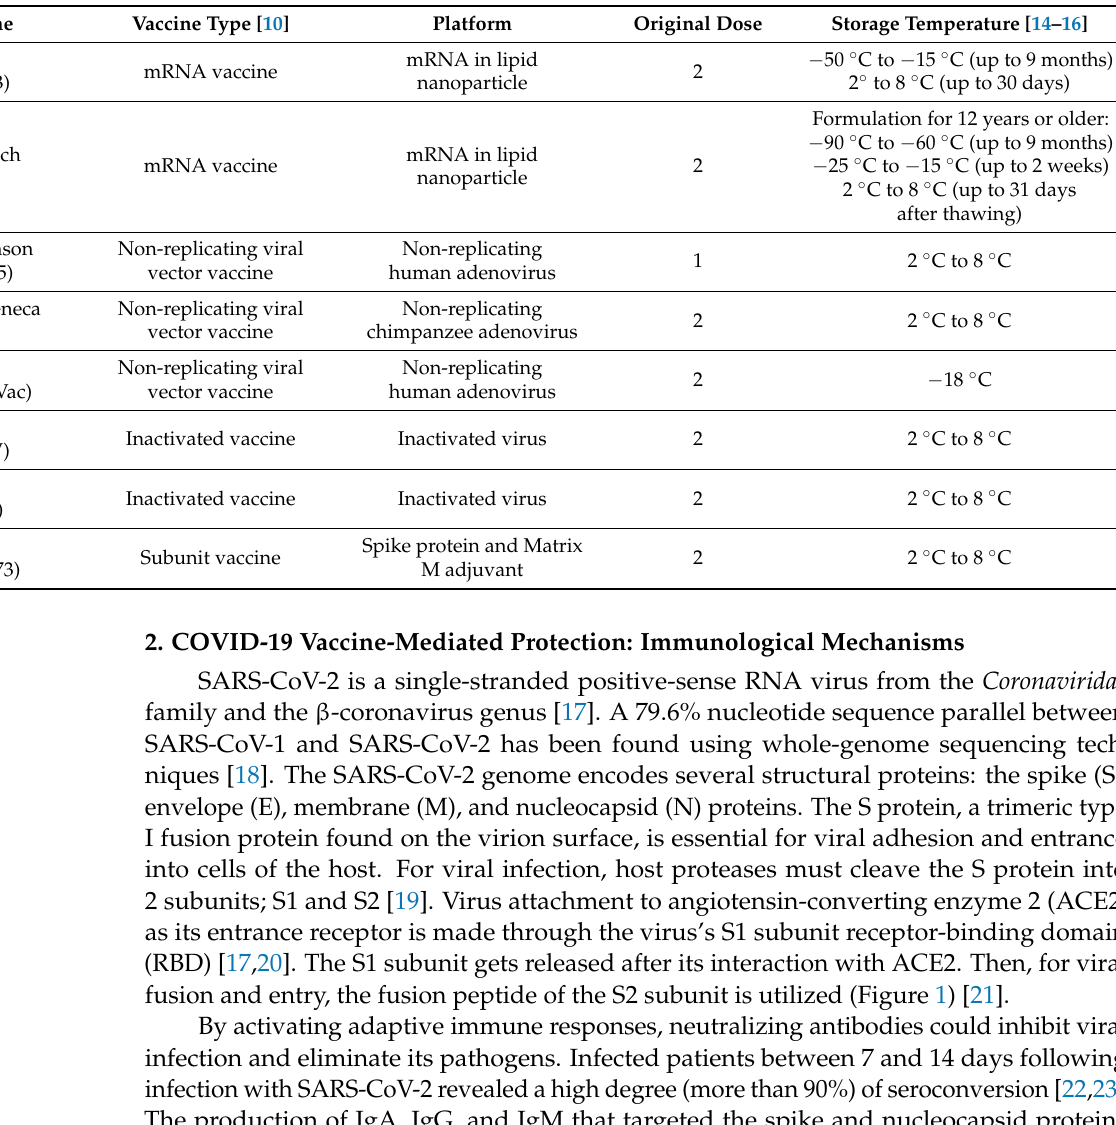
Table 2. Specific characteristics of some COVID-19 vaccines in